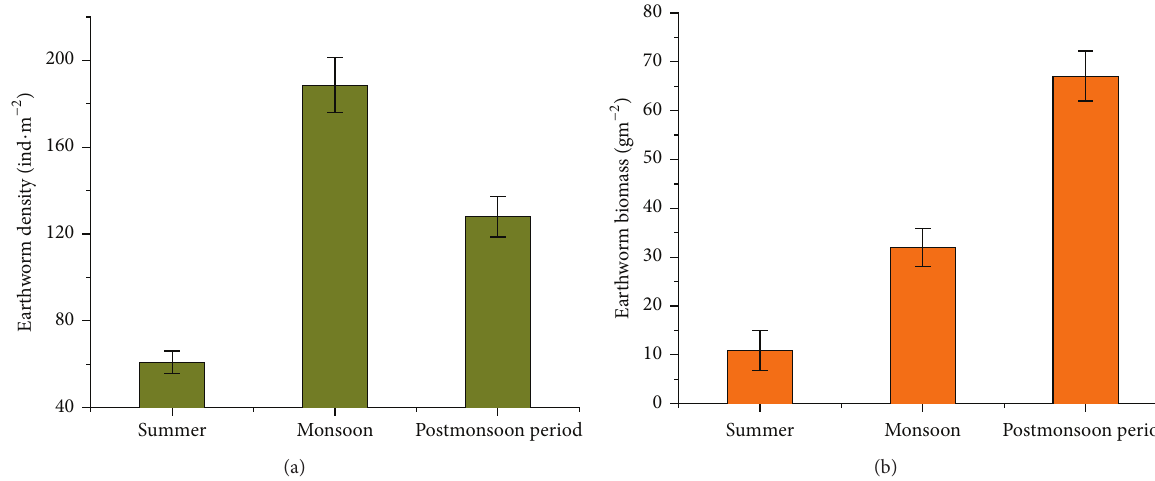
Figure 7: (a) Showing the influence of seasonality on the overall density of earthworm community in the pineapple plantation of Tripura. (b) Showing the influence of seasonality on the overall biomass of earthworm community in the pineapple plantation of